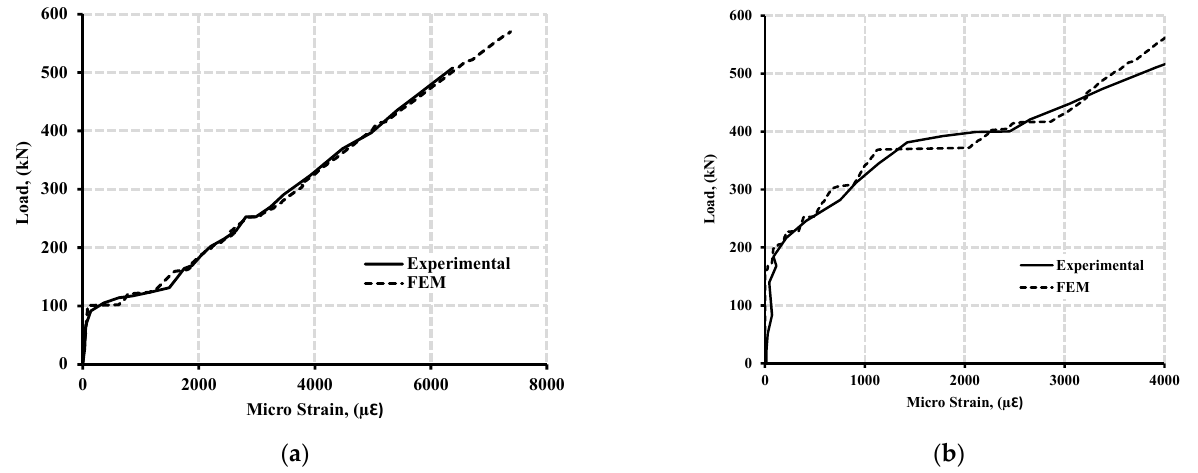
Figure 8. Typical load—strain curve at the hogging moment section of beam specimen GH-1.2-0.63 (with high concrete strength of 80 MPa) for ( a ) the longitudinal reinforcement and ( b ) stirrup.